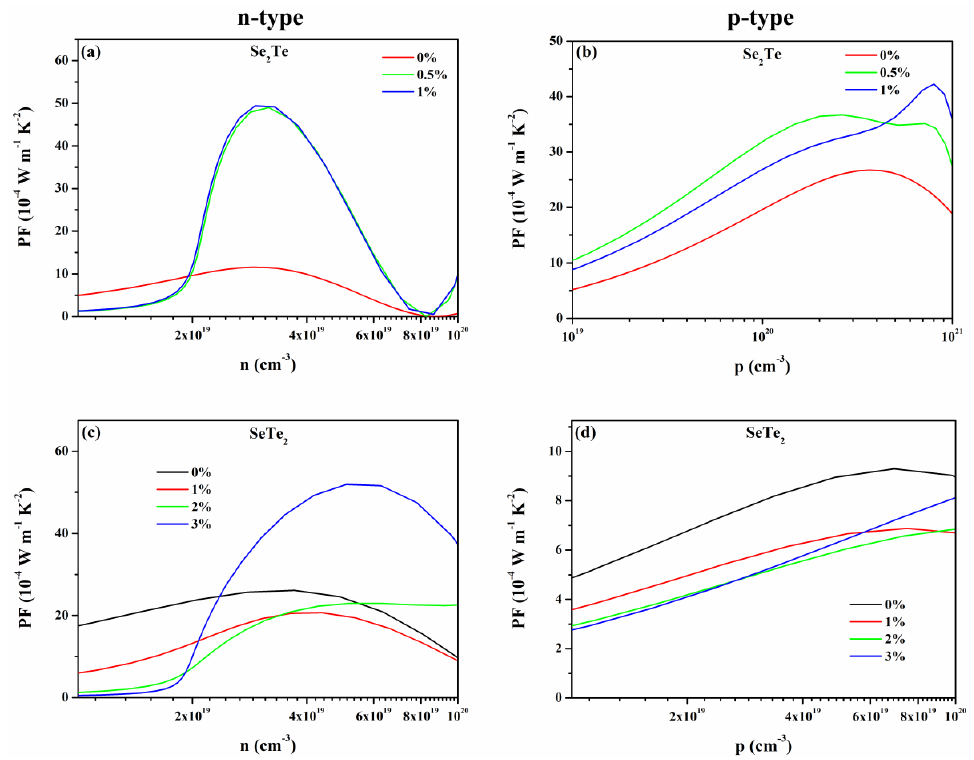
Figure 6. (Color online) The thermoelectric power factor PF of ( a , b ) Se 2 Te and ( c , d ) SeTe 2 monolayers under tensile strains at 300 K as a function of concentration, respectively.